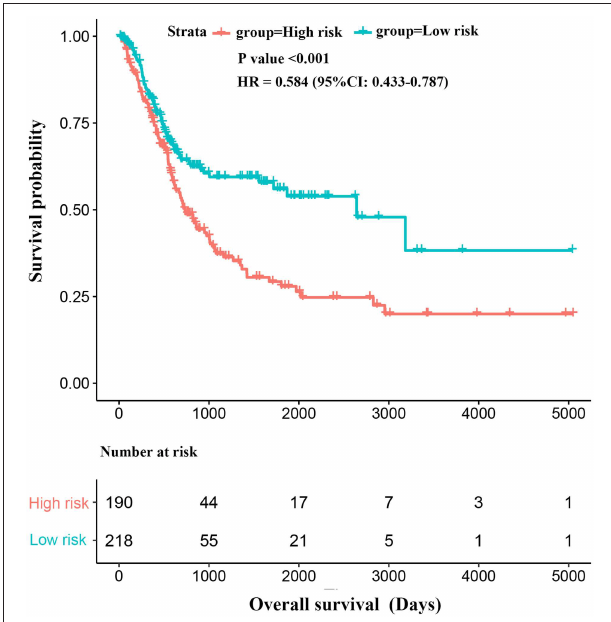
FIGURE 3 | Kaplan-Meier survival analysis of overall survival of patients with bladder